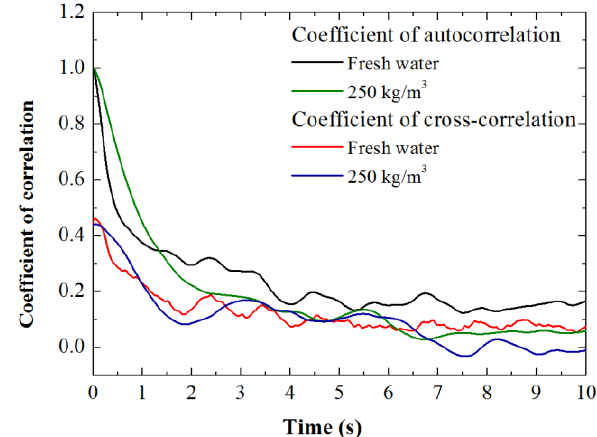
Figure 13. Relationships between coefficient of association at peak pressure and time for fresh water and sediment-laden flow of 250 kg/m 3 concentration at an upstream water head of 1.90 m.